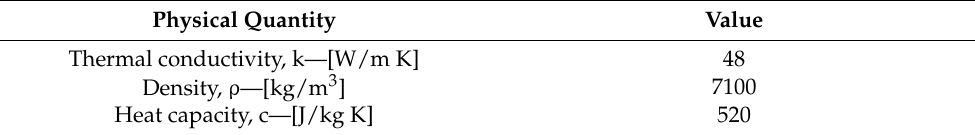
Table 1. Thermo-physical properties of the cast iron